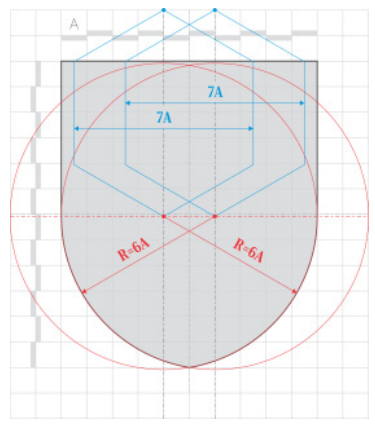
Figure 16. The MCHS standard shield.